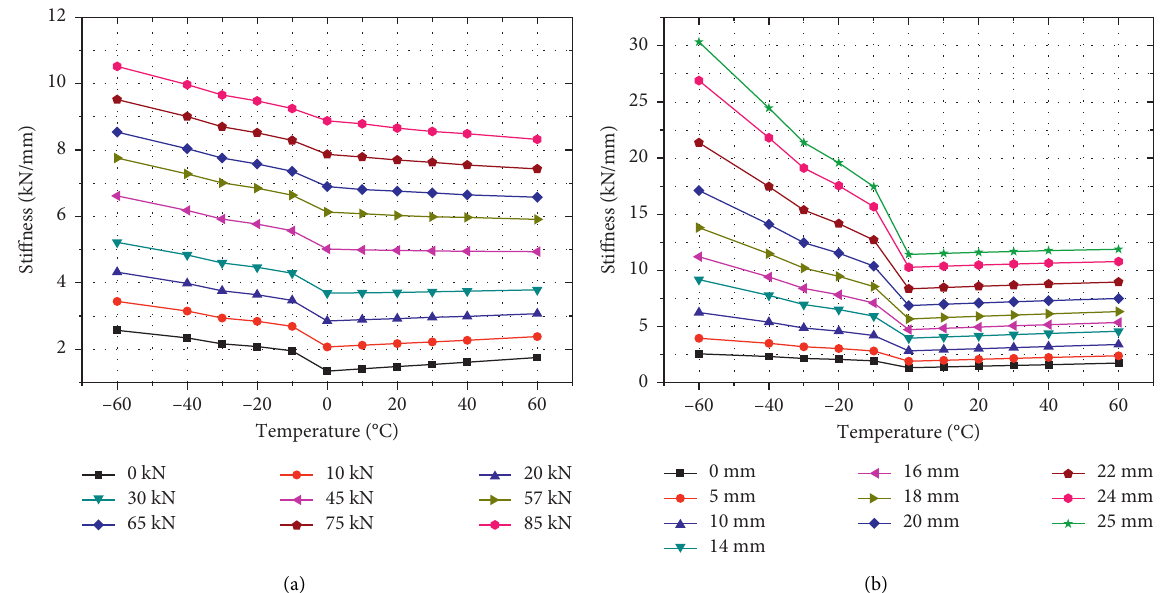
Figure 8: Curves for change in stiffness. (a) Stiffness variation under different temperatures and prepressures. (b) Stiffness variation under different temperatures and compression